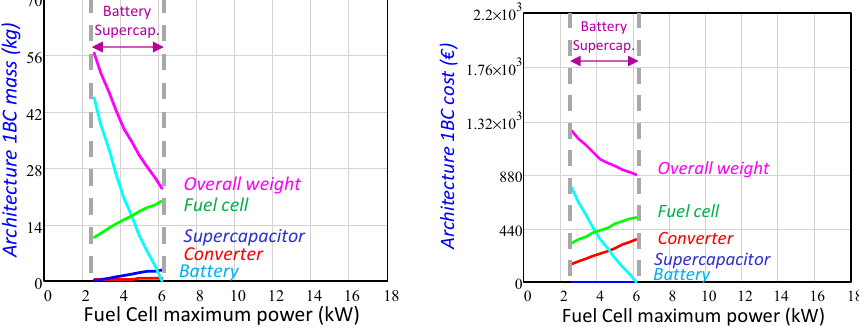
Figure 15. Architecture 1BC mass and cost.